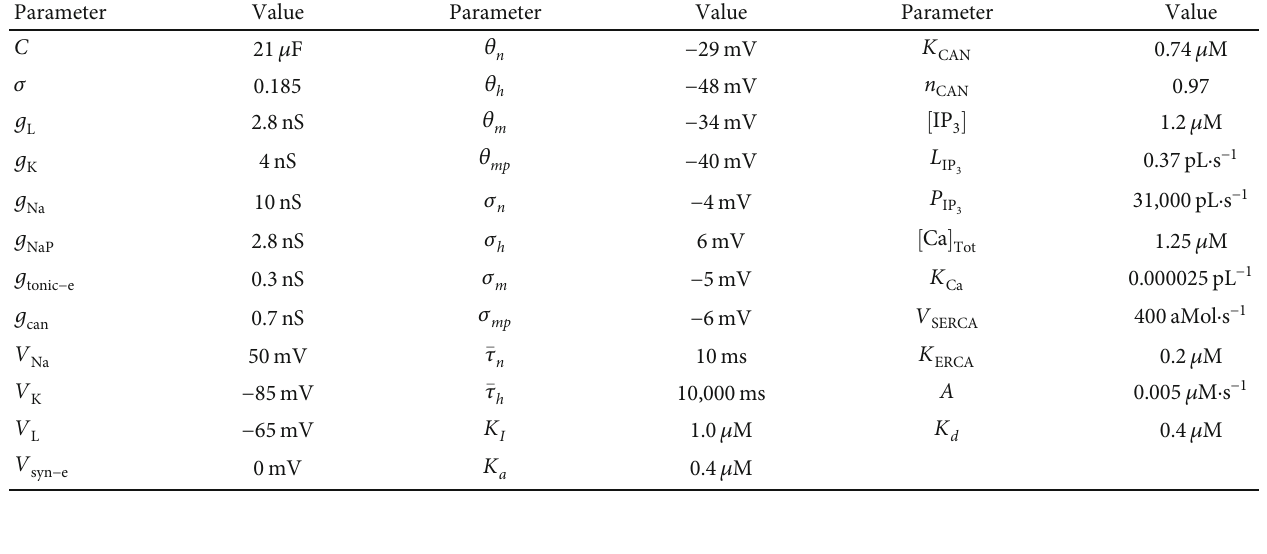
Table 1: Parameter values used in the